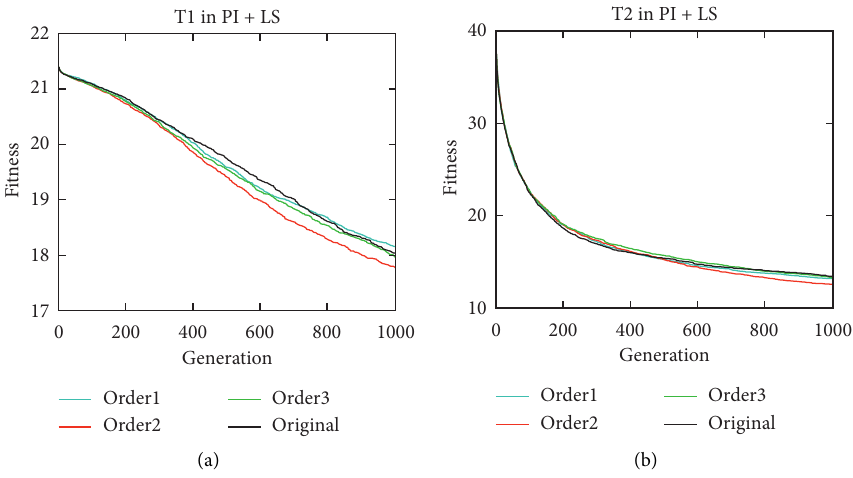
Figure 9: Convergence of MFEA for problem 6 (PI+LS).